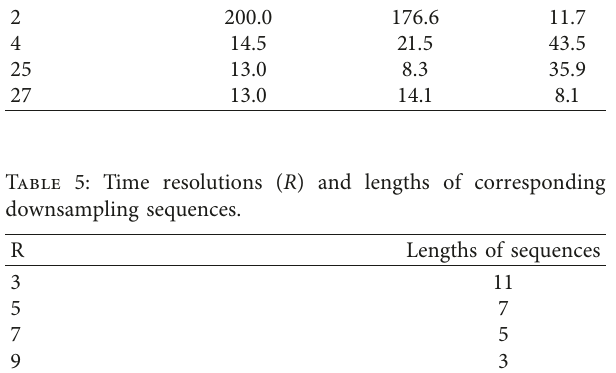
Table 4: Prediction results of VF values. Video number